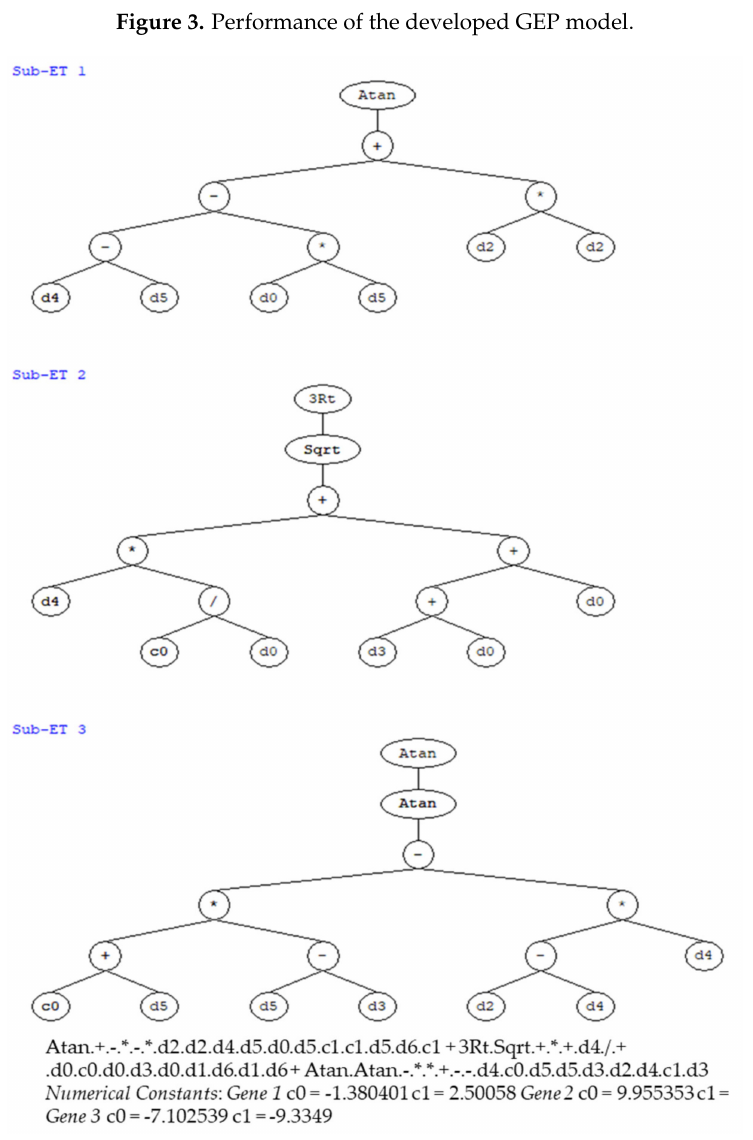
Figure 4. Expression tree and genes for the proposed GEP